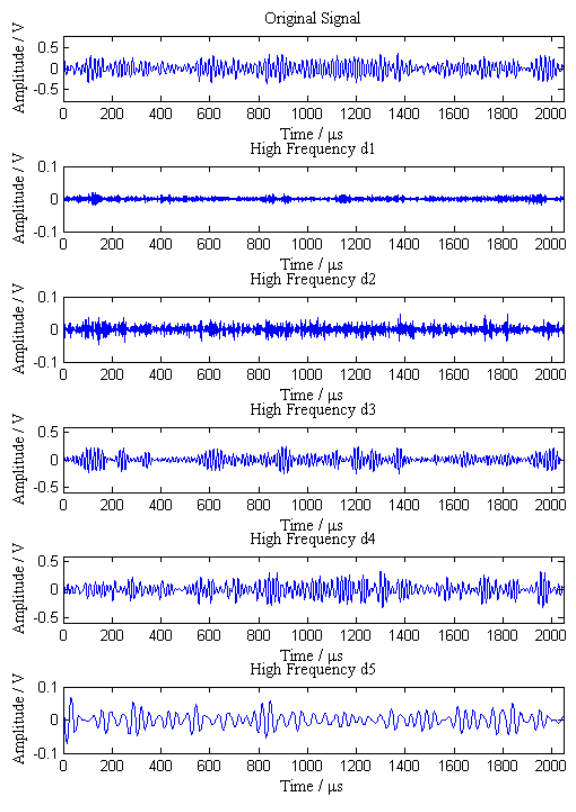
Figure 8. Signal decomposition of node